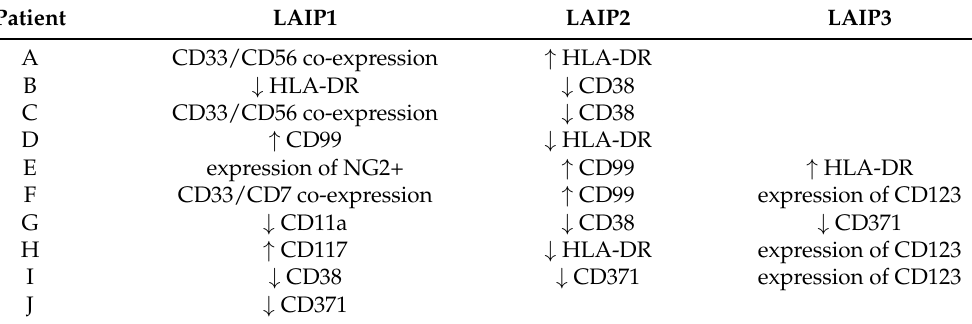
Table A4. Details on the LAIPs identified in manual gating for the patients present in the data set used.